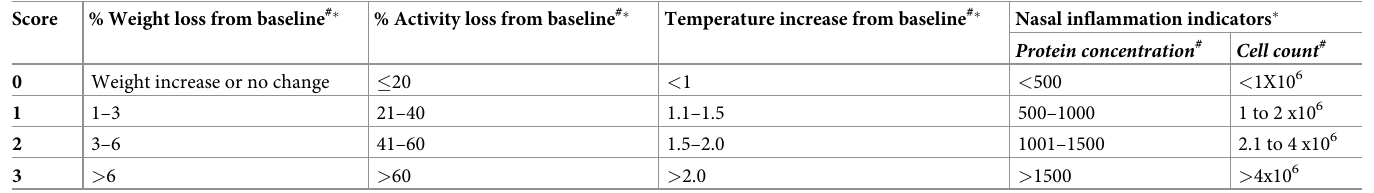
Table 2. The clinical score card used to determine severity of clinical signs in ferrets infected with influenza viruses.